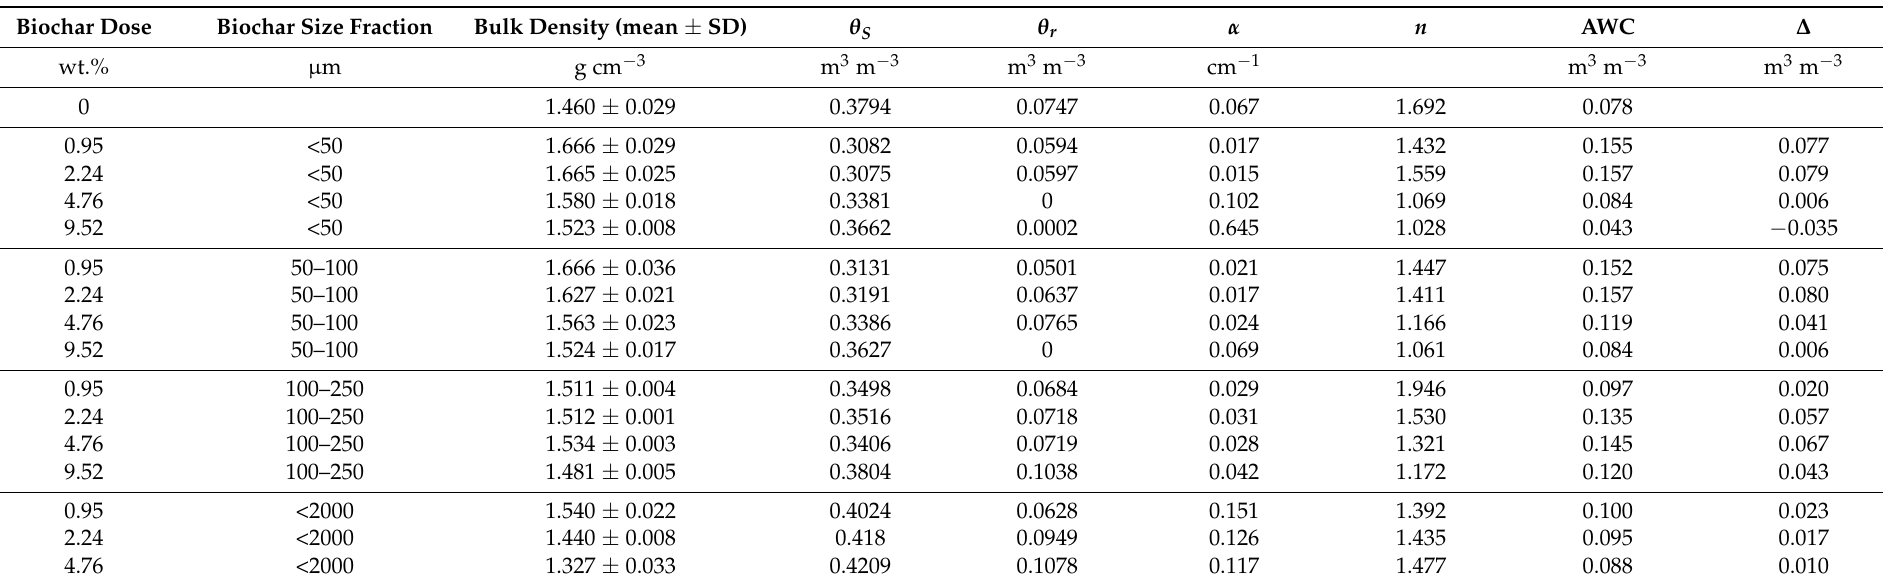
Table 2. Unimodal van Genuchten model parameters according to Equation (3). The averaged bulk densities of the samples and Available Water Content (AWC) values derived from the difference between soil water contents at pF = 2.0 and 4.2. Biochar Dose ∆